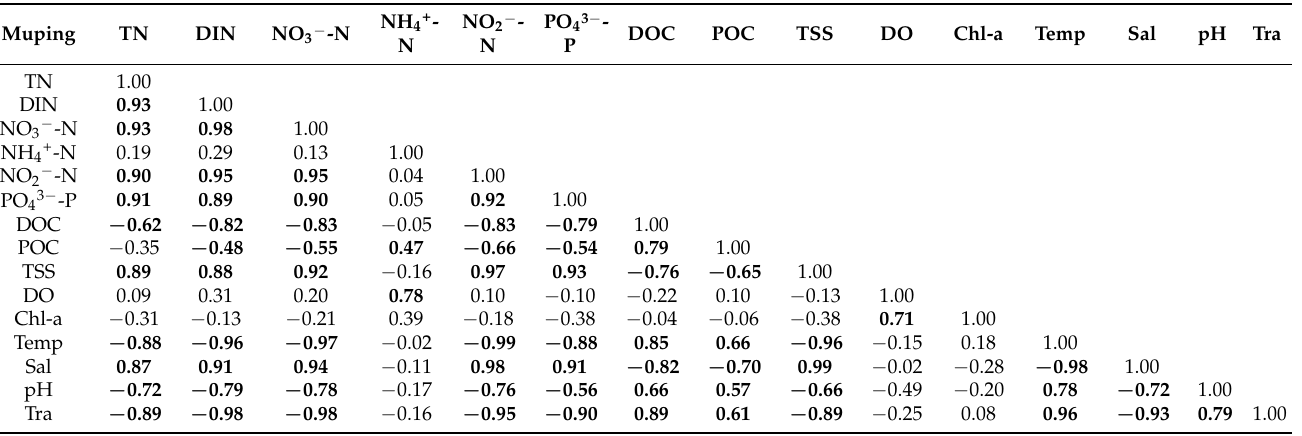
Table 6. Pearson correlation coefficient between the water quality parameters based on the data from the stations at Muping. The bold numbers indicate a statistically significant correlation ( p < 0.05). The abbreviations are the same in Table